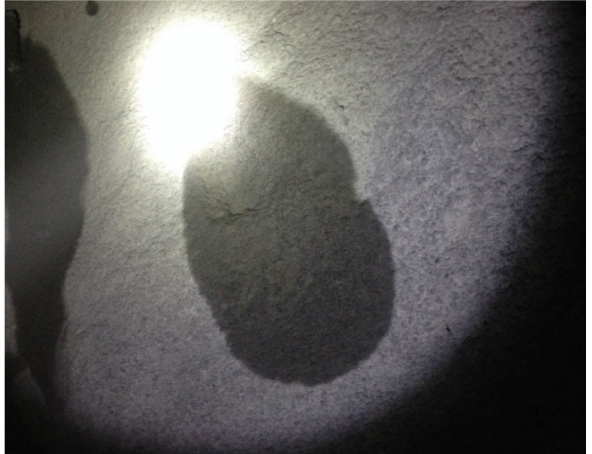
Figure 22. CFIL60 ARGF grouting anti-seepage e ff